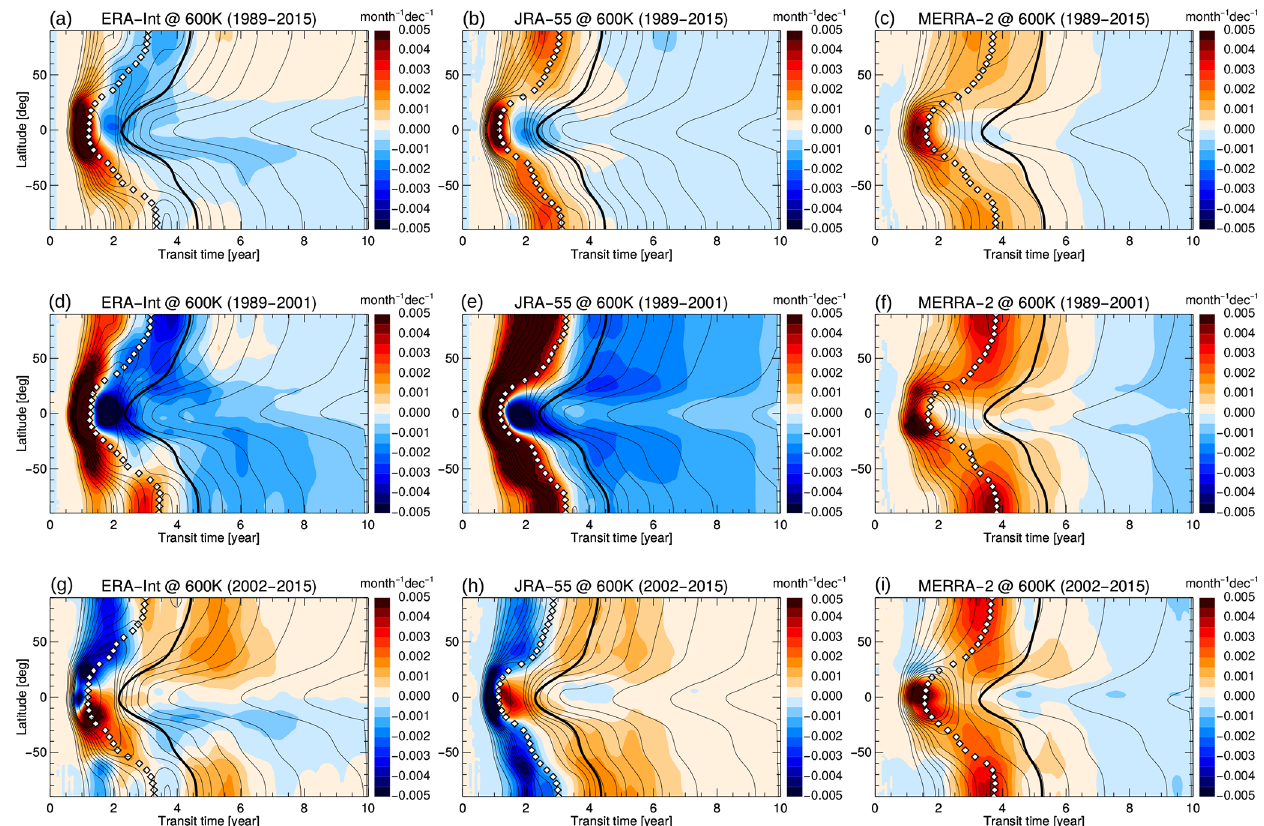
Figure 9. Same as Fig. 8, but at the 600K potential temperature